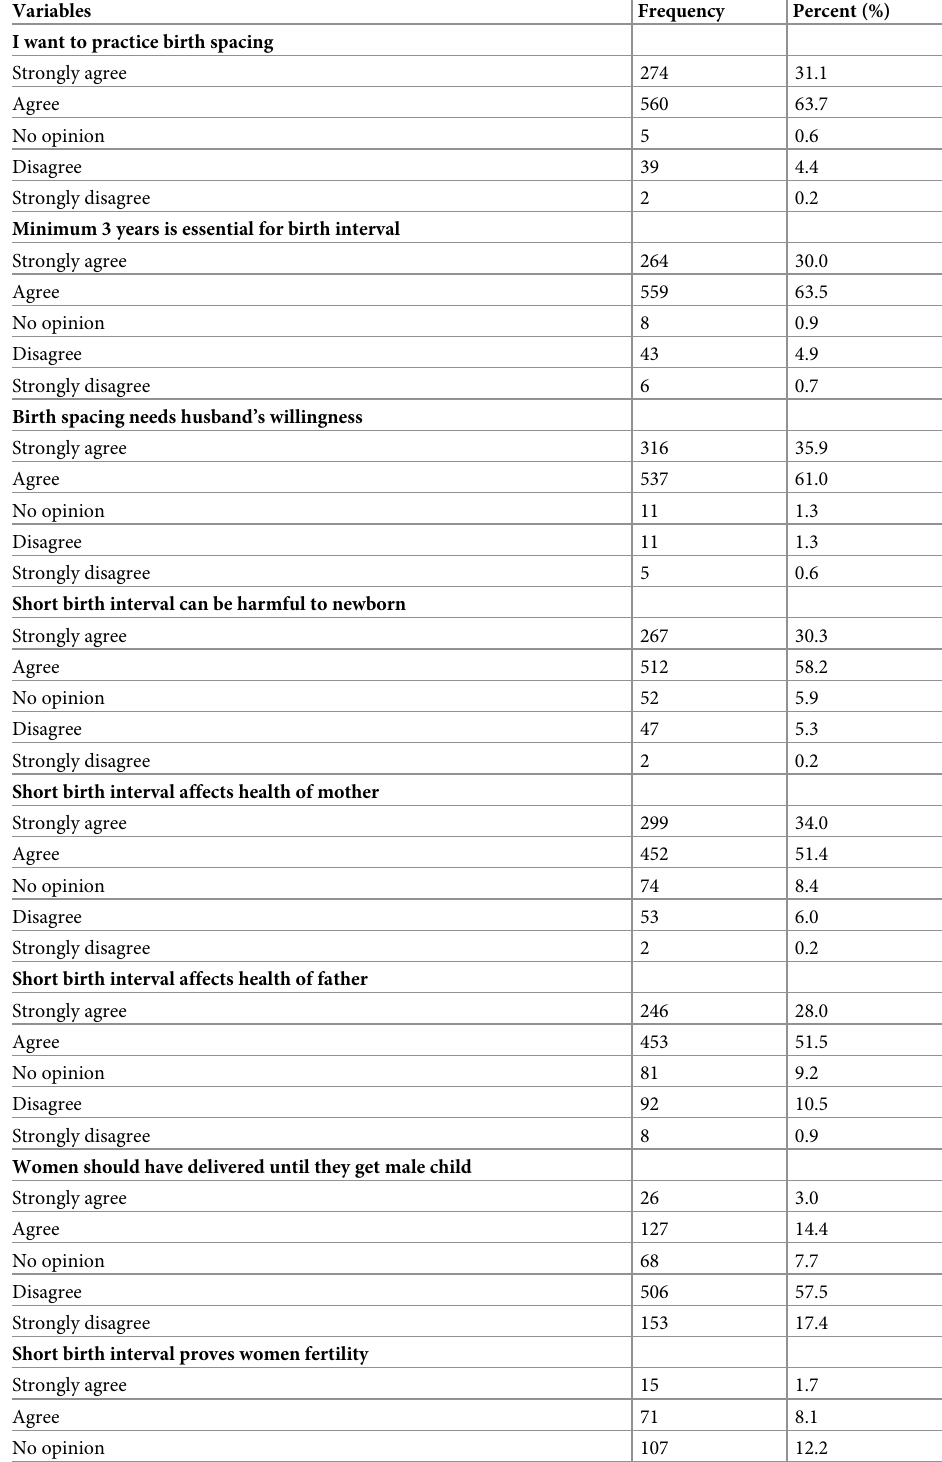
Table 4. Attitude of study participants towards short birth interval in Dembecha district, North West Ethiopia, 2019 (n =